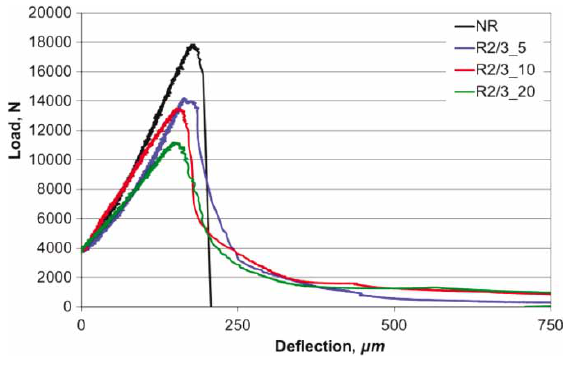
Fig. 9. The function of stress and deflection when 0/1 fraction is used